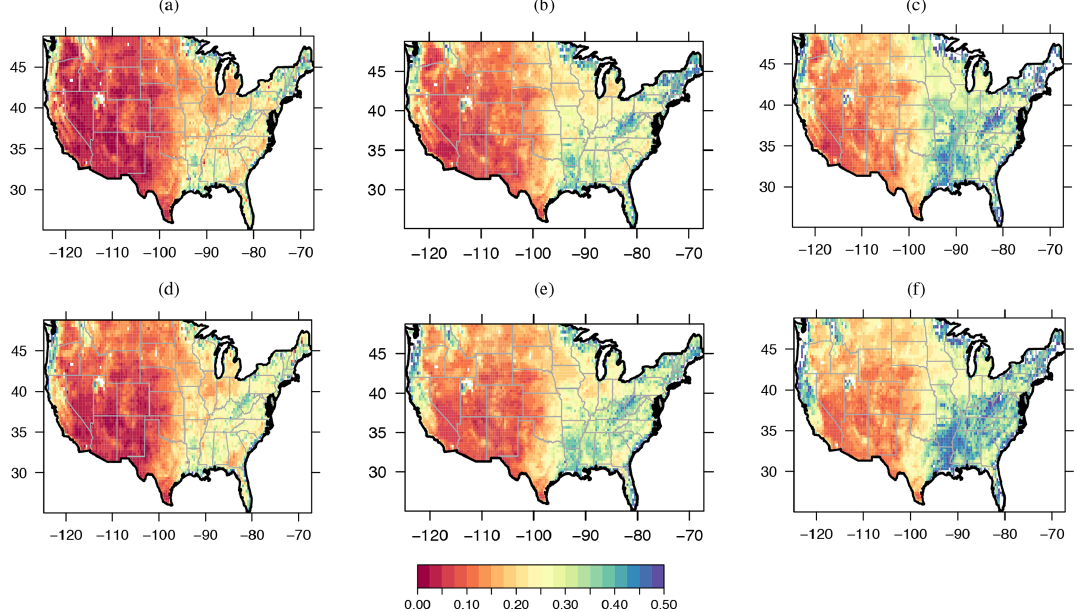
Figure 2. (a–c) SMAP soil moisture values for the warm season during summer for SPL3SMP top 5cm soil moisture (a) at the 20th percentile, (b) at the average soil moisture, and (c) at the 80th percentile; (d–f) same as the top row, but for the cold season. Total period is from 1 April 2015 to 31 December 2017. The soil moisture unit is m 3 m − 3 .